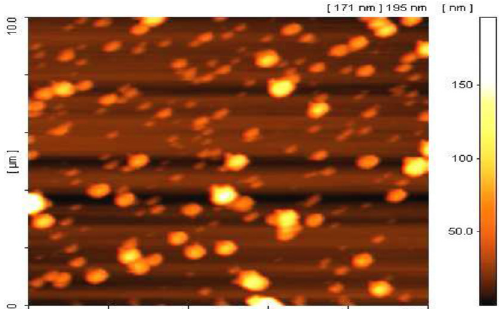
Fig. 6. AFM image of sample with B sample (nano-composite containing high Cu content) before calcinations.